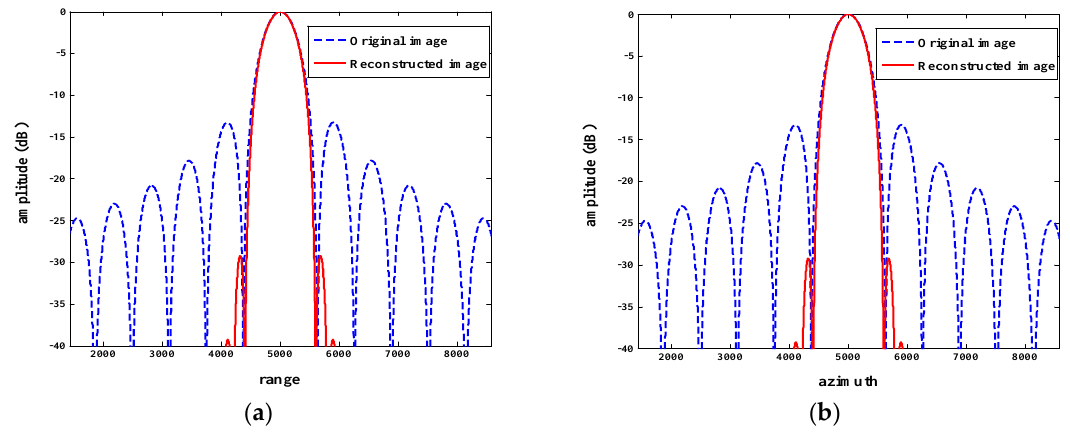
Figure 3. Profile map analysis of the original image and reconstructed image. ( a ) Profile map of original image and reconstructed image in range direction; ( b ) profile map of original image and reconstructed image in azimuth direction. The blue dotted line and the red solid line represent the profile map of the original image and reconstructed image, respectively.